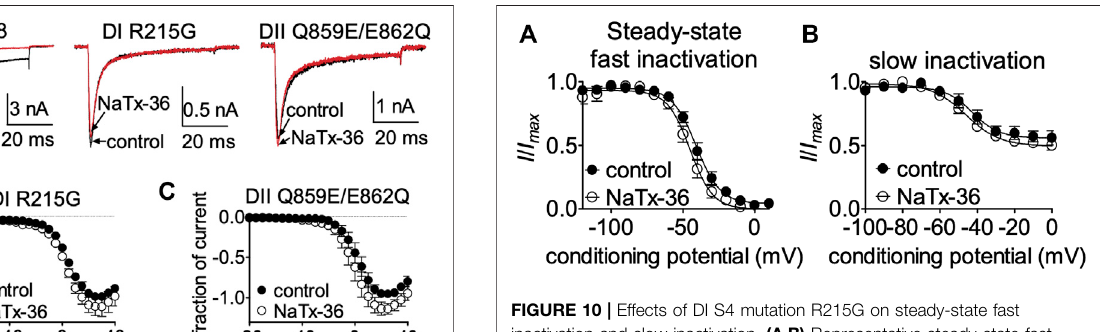
maximum amplitude of control peak current. NaTx36 (100 nM) failed to inhibit TTX-R Na + currents recorded from the DI voltage sensor mutant (R215G) channels. The fraction of current was 110.9% ±11.1% of control current (control, n = 3; NaTx36, n = 3; p = 0.23) ( Figure 9B ). In addition, NaTx36 (100 nM) failed to inhibit TTX-R Na + currents recorded from the DII SS2 – S6 pore loop (Q859E/E862Q) mutant channels. The